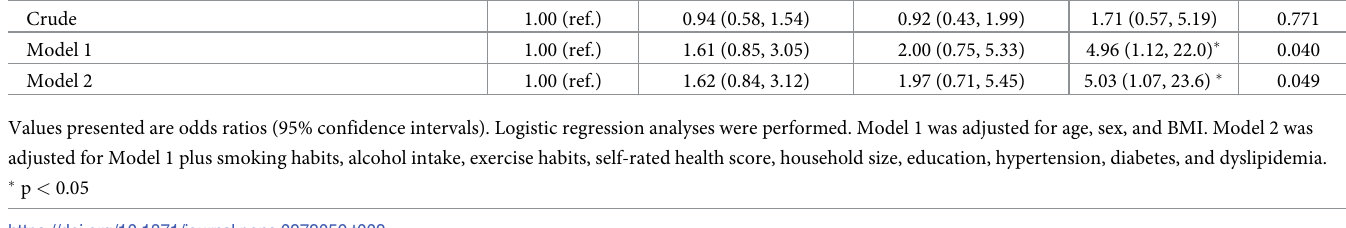
Table 2 shows the OR (95% CI) for influenza infection according to the VFA group among 2019 participants. After multivariate adjustment, the higher VFA group was significantly asso- ciated with increased influenza infection (Model 2: p for trend = 0.049). The OR for the